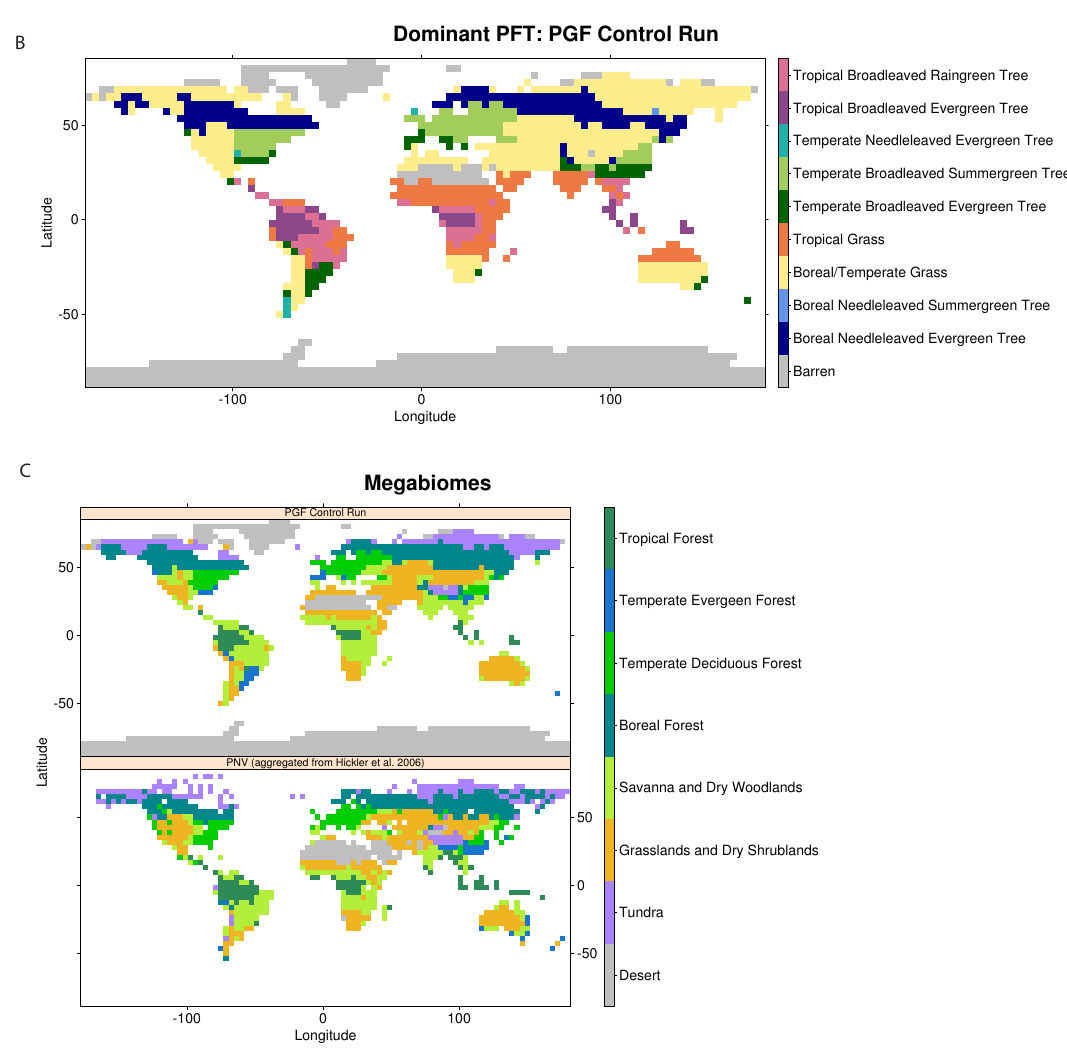
Figure C1. (a) Biomes (see Appendix B for classification) for the present-day control run compared to potential natural vegetation from Hickler et al. (2006), (b) dominant PFT in the present-day control run, and (c) biomes in (a) aggregated to megabiomes (see Table